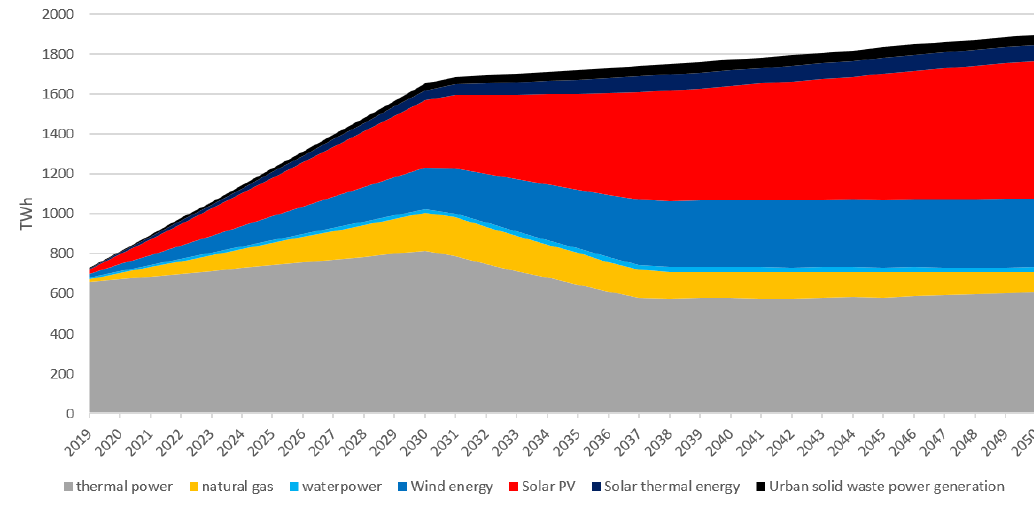
Figure 8. Power generation change in Inner Mongolia under the benchmark scenario.